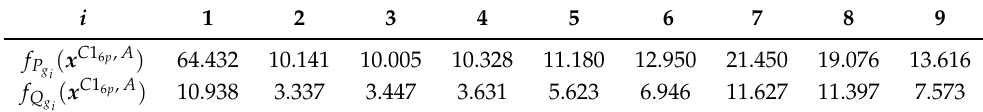
Table 7. Values of the 18 indices produced by x C 1 6 p , A .